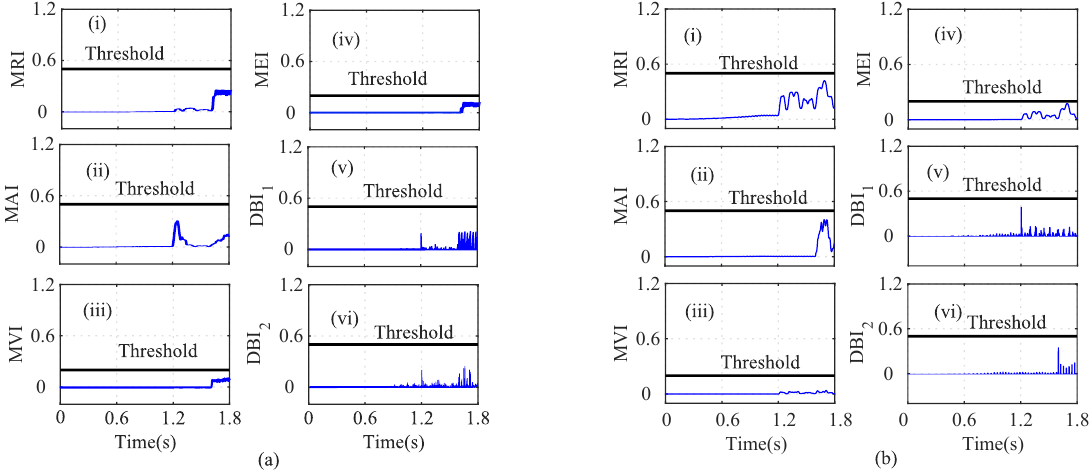
Figure 9. Analysis of residuals for ( a ) W and ( b ) V α using index-based method ((i) MRI, (ii) MAI, (iii) MVI, (iv) MEI, (v) DBI 1 and (vi) DBI 2 ) for incipient I α fault and abrupt V β fault at t = 1.256 s and t = 1.60